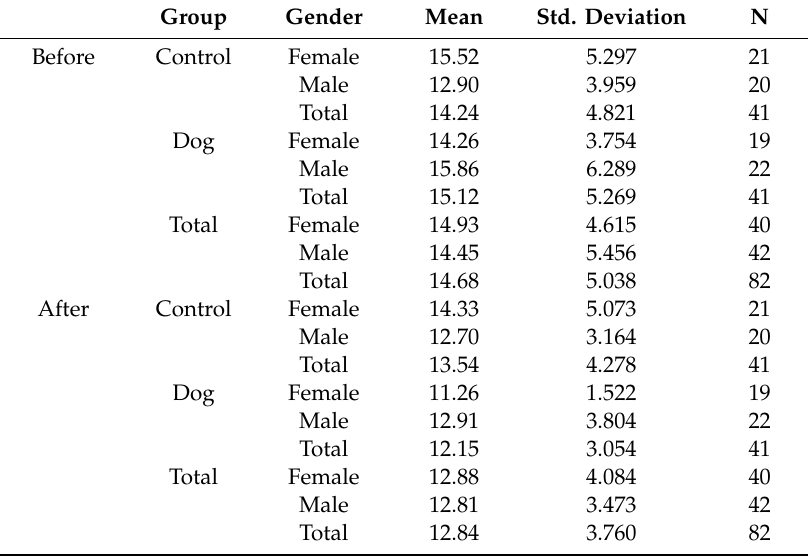
Table 7. Descriptive Statistics: Negative A ff ect and